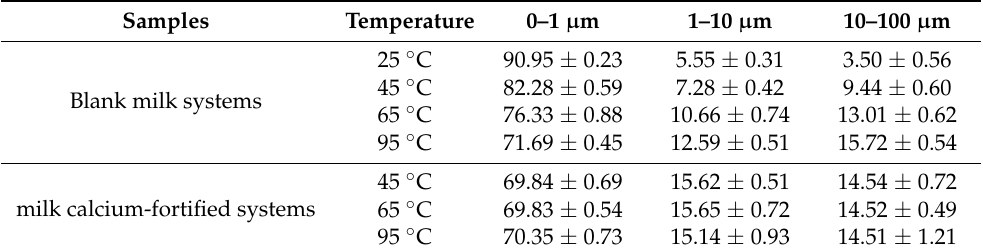
Table 3. The percentage of different particle sizes in the different milk systems at various temperatures. Samples